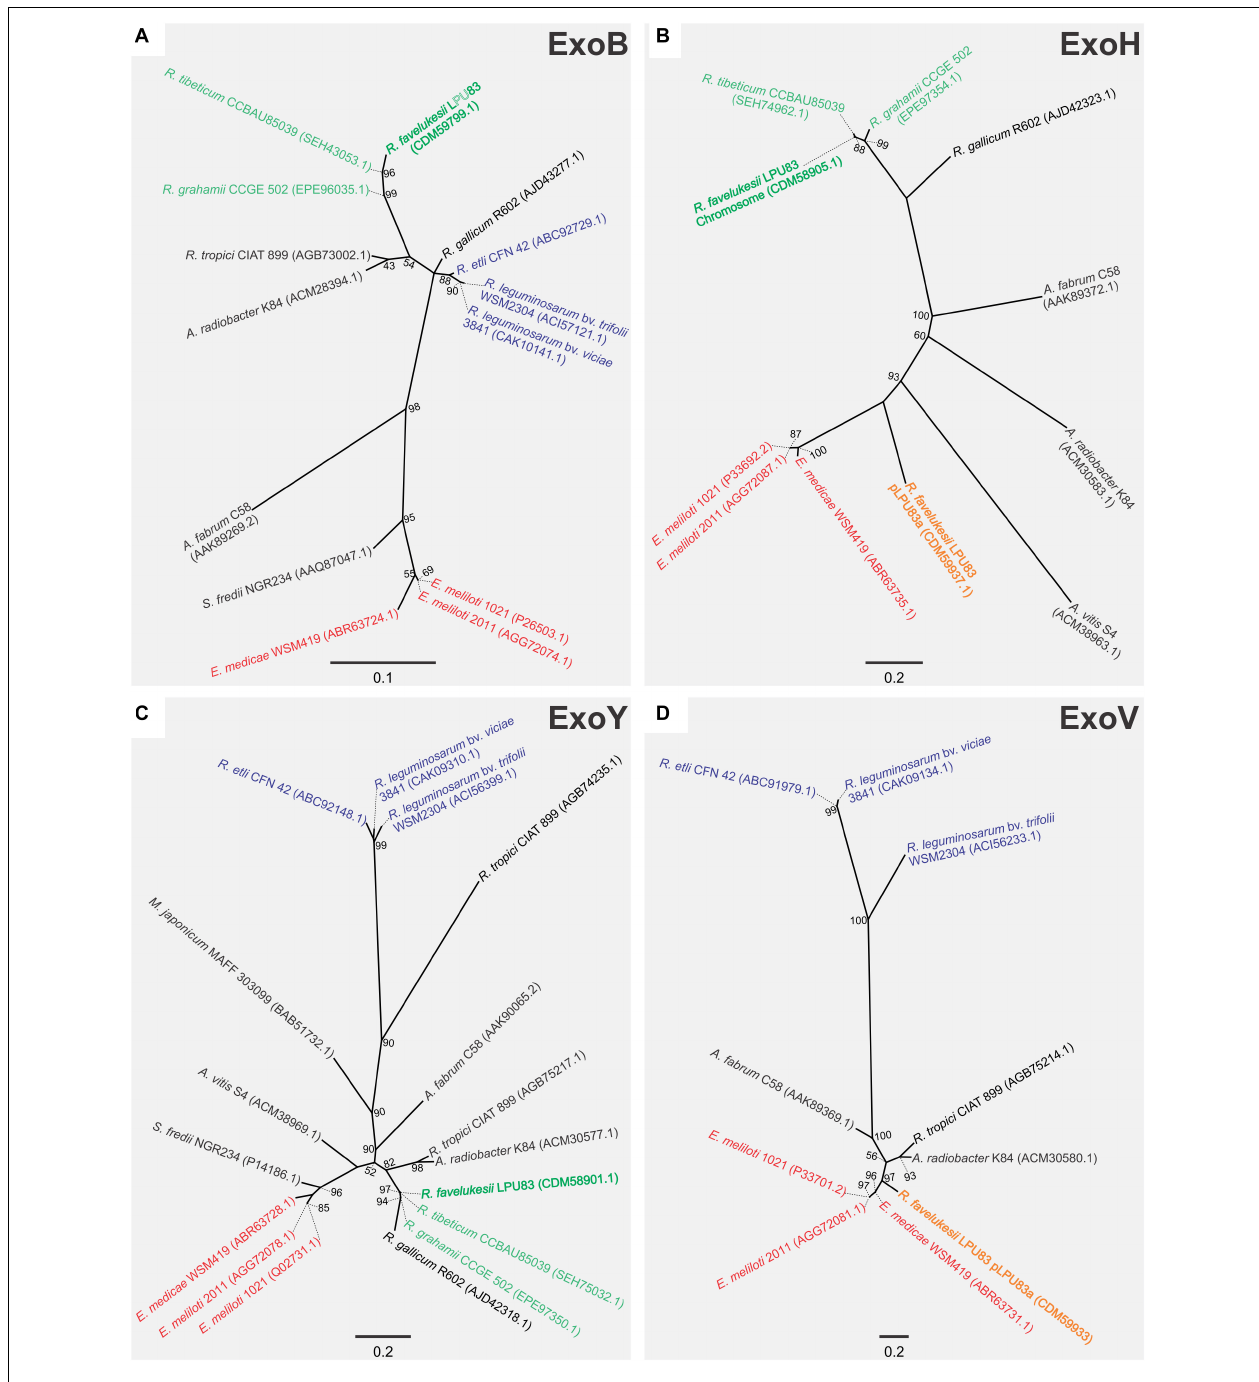
FIGURE 2 | Phylogenetic analyses of EPS I genes of LPU83. Phylogenetic tree based on (A) ExoB (only in the chromosome of LPU83), (B) ExoH (in the chromosome of LPU83 and pLPU83a), (C) ExoY (only in the chromosome of LPU83), and (D) ExoV (only in the plasmid pLPU83a). Analyses were conducted by means of the Maximum Likelihood method. Support values (SH like × 100) greater than 50 are indicated at the nodes. Bars indicate substitution/site.